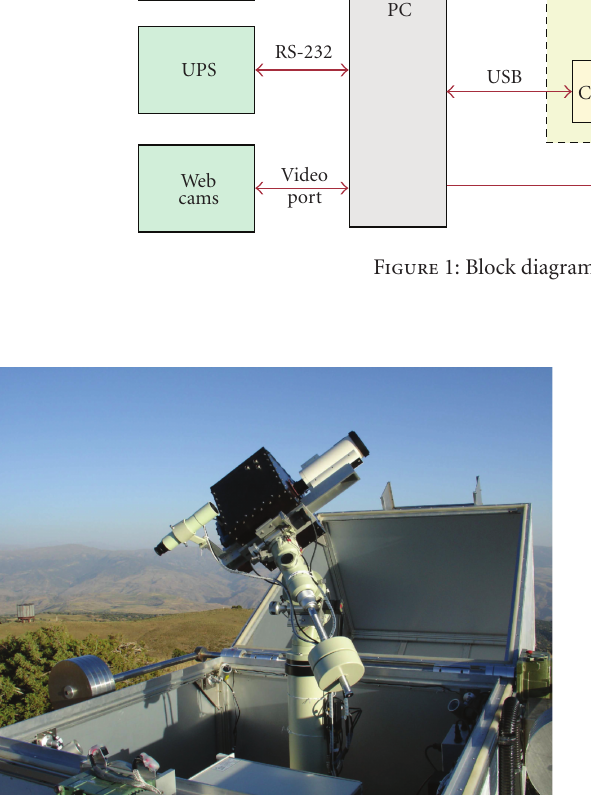
Figure 2: Telescope at the Maidanak Observatory,